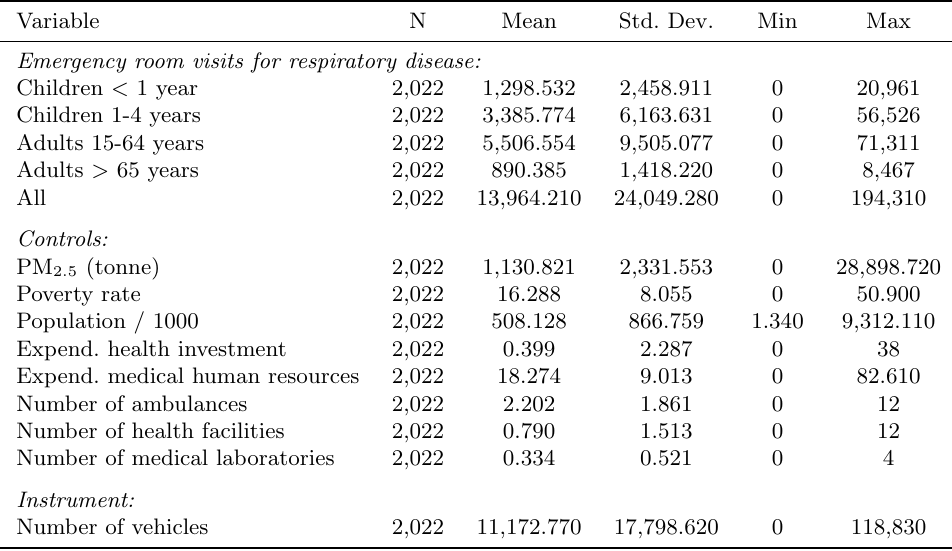
Table 1: Summary